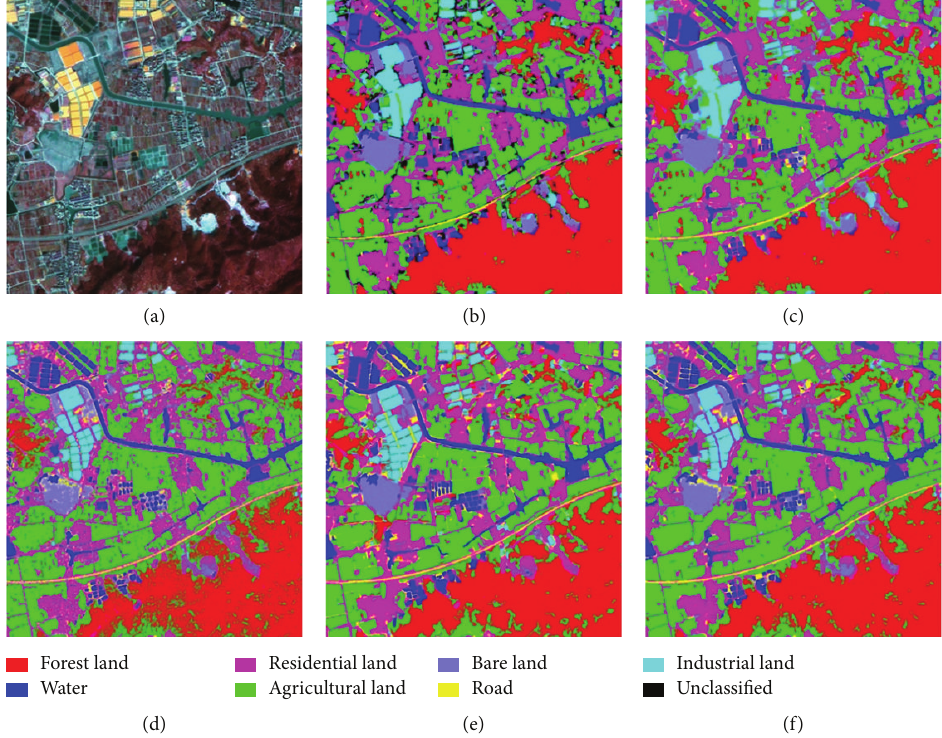
Figure 5: SPOT-5 images and classification results. (a) is the fused pseudocolor synthetic image, (b) is the primitive mapped classification image, (c) shows the final classification result obtained by the proposed method, and (d) is result of the pixel-based SVM. The classification result of the object-oriented SVM is shown in (e), and the SVMMV is shown in (f).